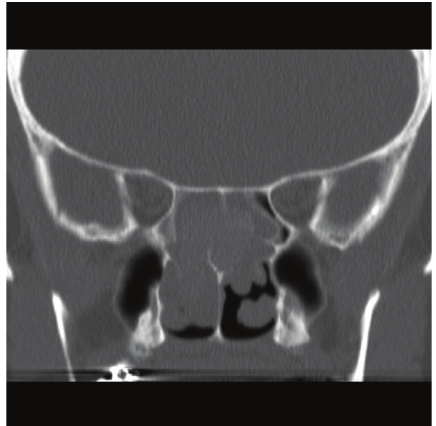
Figure 2: Coronal CT image showing bilateral opacification and polyposis in both sphenoethmoidal